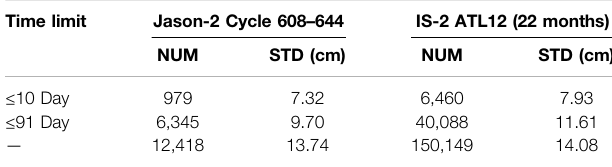
TABLE 2 | Statistical information of crossover differences under intermission situation ( “ _A ” and “ _D ” denote ascending and descending passes, J indicates Jason, and 1/2/3 and L/R represent the corresponding IS-2